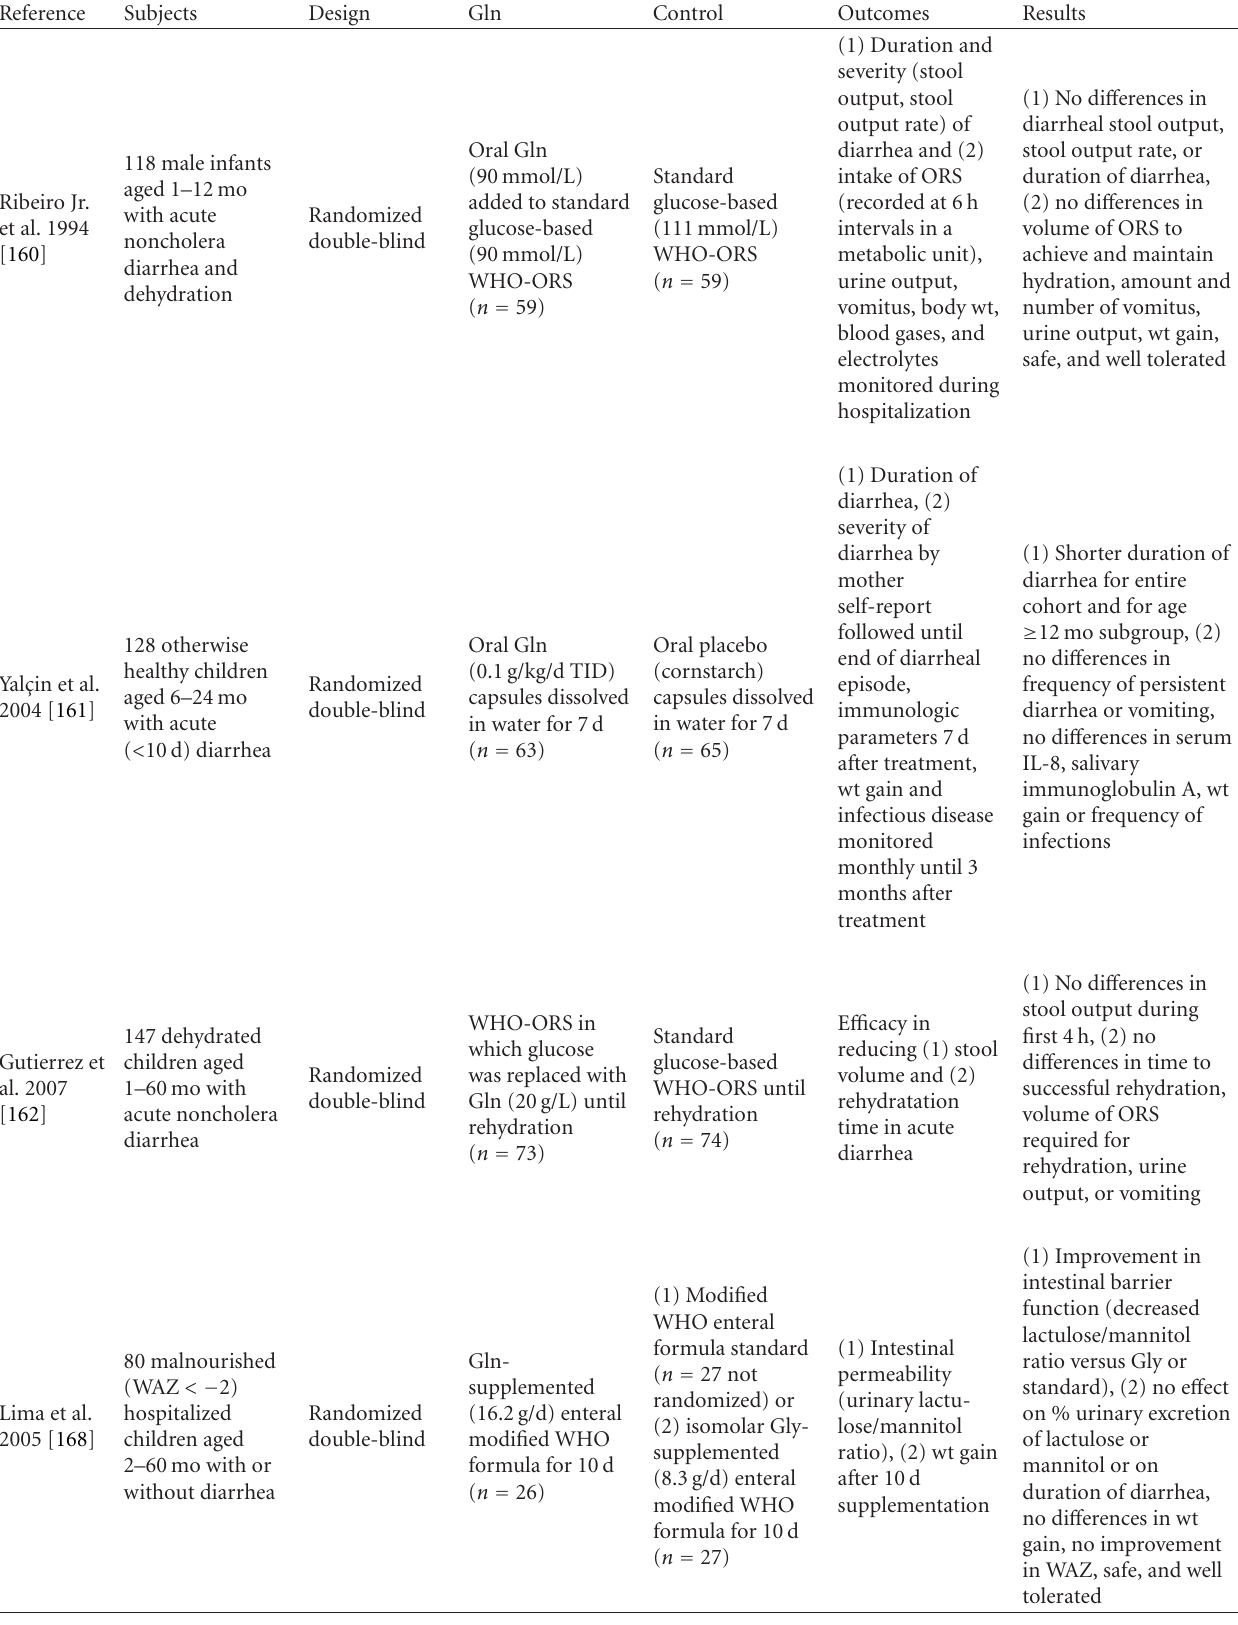
Table 4: Enteral glutamine supplementation in children with diarrheal